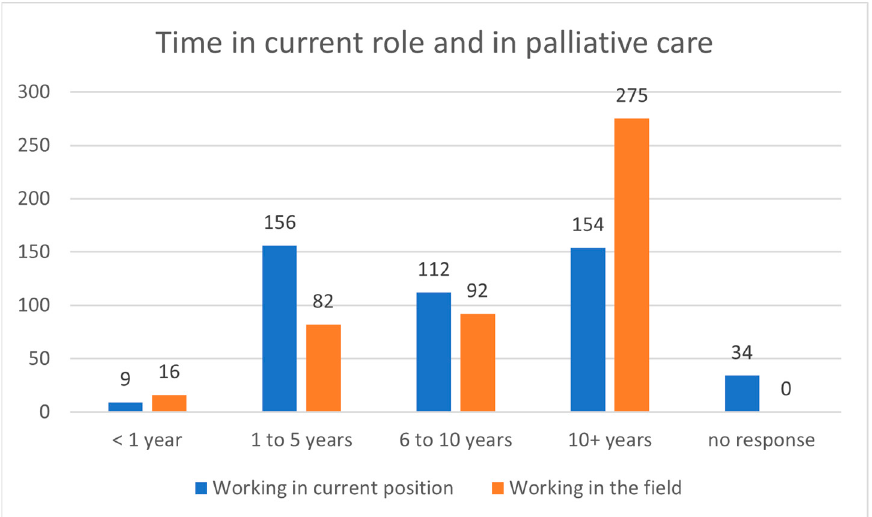
Figure 3. Time in current role/time in palliative care (Q10 & Q11).